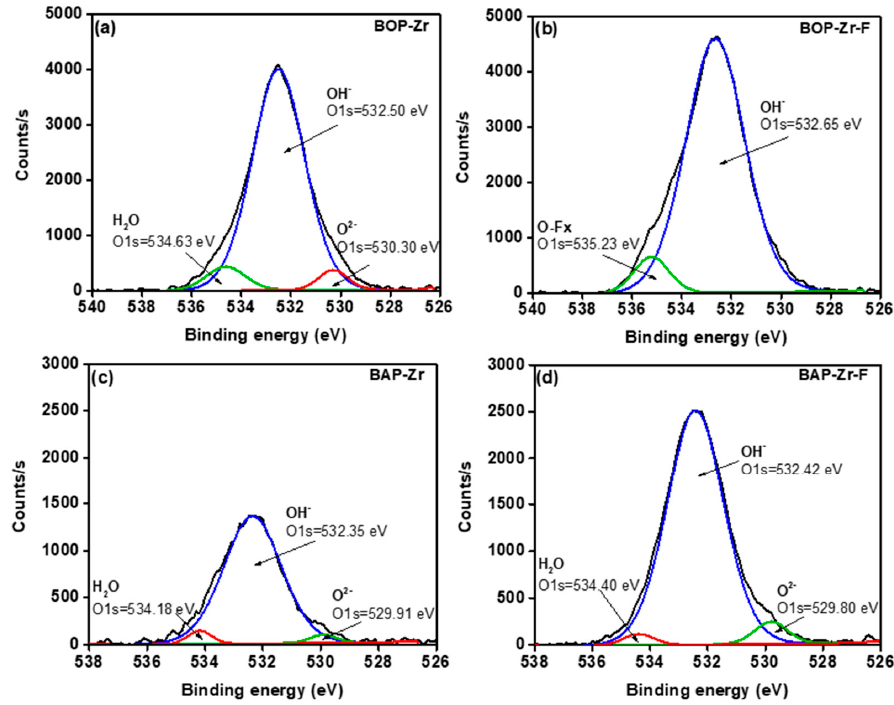
Figure 10. Deconvoluted XPS spectra for O1s, ( a ) BOP-Zr, ( b ) BOP-Zr-F, ( c ) BAP-Zr, and ( d ) BAP-Zr-F.